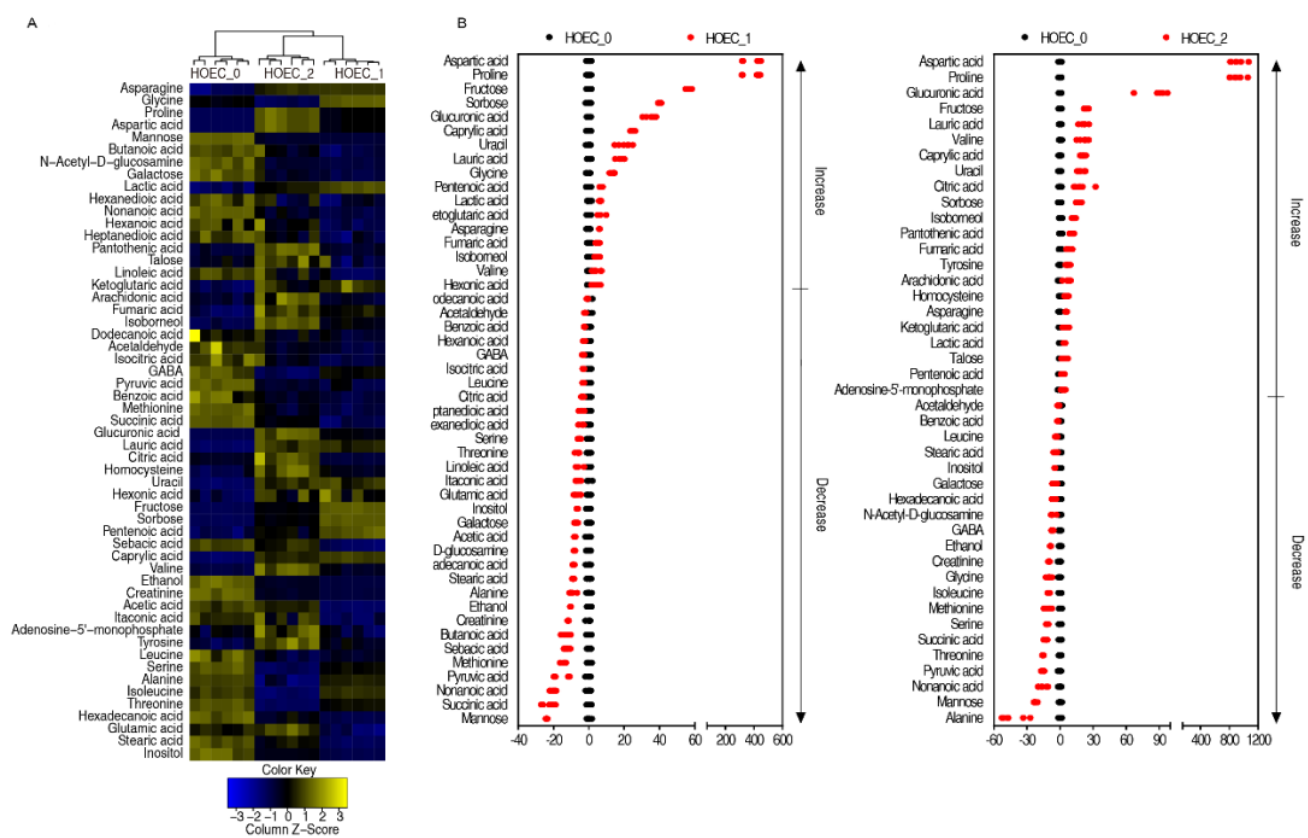
Figure 6. Differential metabolites of HOEC cells after cisplatin treatment. Cluster analysis of the differential metabolites ( A ). The Z value distribution map of the differential metabolites ( B ). HOEC_0, HOEC_1 and HOEC_2 represent the HOEC cells treated with cisplatin for 0 h, 24 h or 48 h.